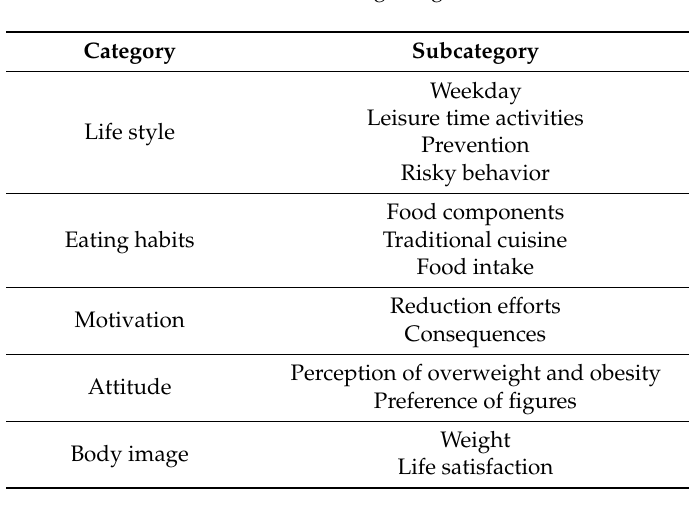
Table 4. Resulting